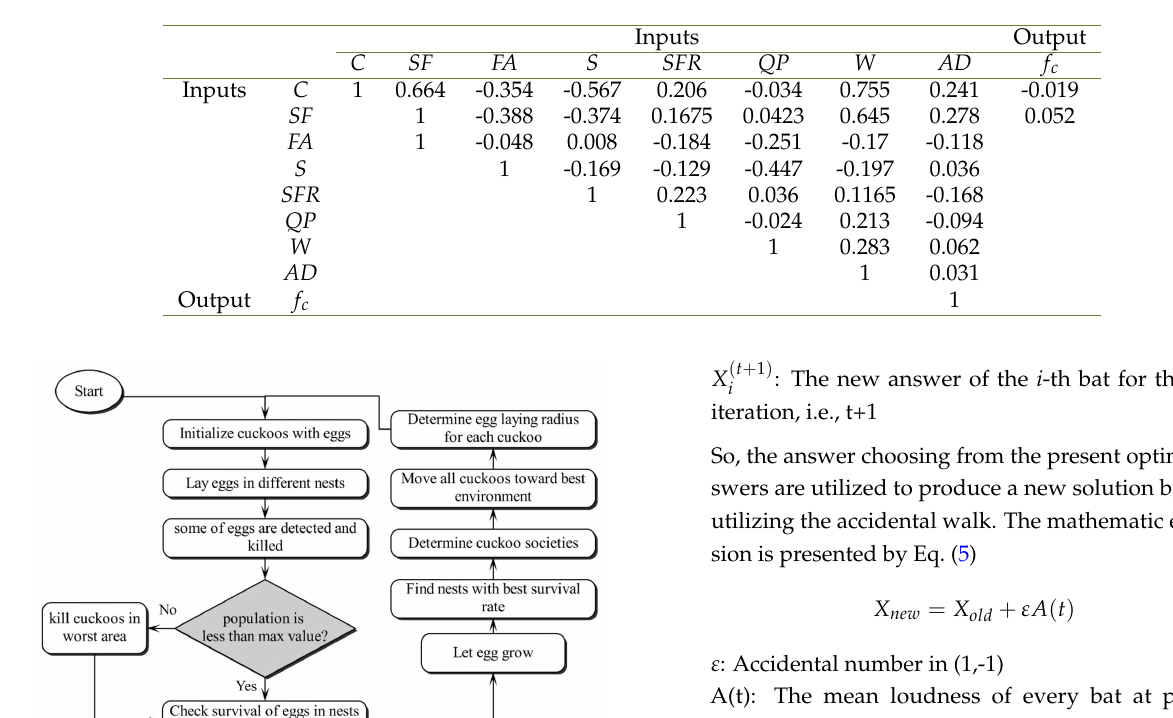
Table 2. Correlation matrix for variables.